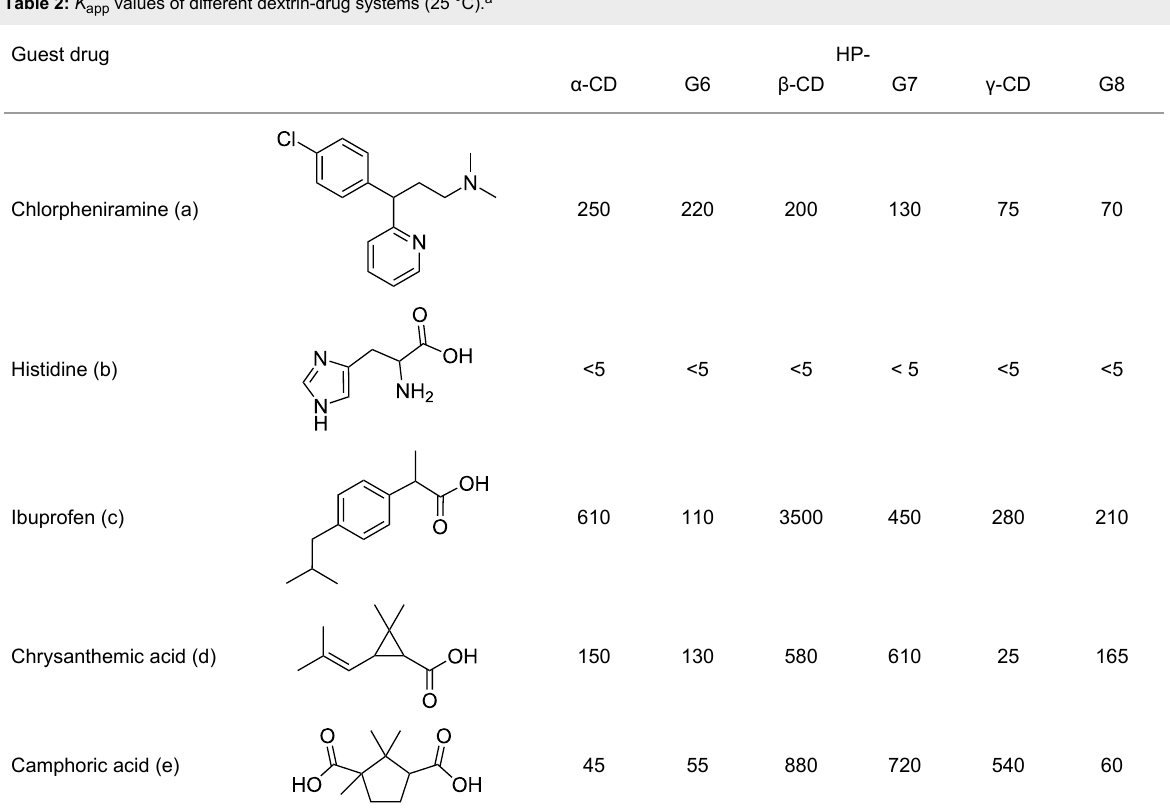
Table 2: K app values of different dextrin-drug systems (25 °C).